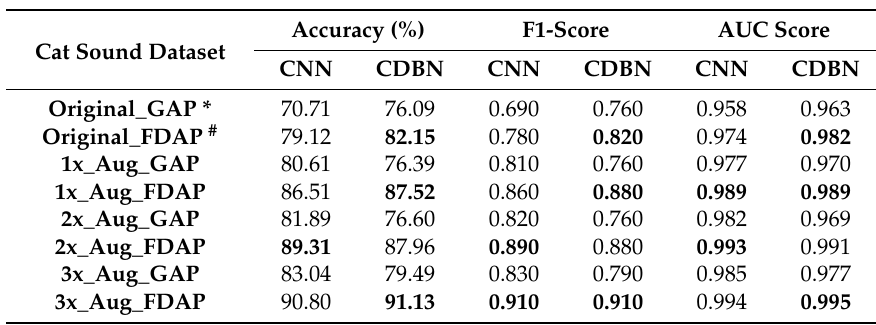
Table 3. The accuracy, F1-Score and area under ROC curve comparison of CNN and CDBN feature using ensemble classifier on original and augmented datasets. The advantage of FDAP over GAP in each layer feature map of two networks using various datasets are denoted by “GAP” and “FDAP” at the end of corresponding dataset. Bold numbers mark the best-performing algorithm(s) for a dataset using FDAP in a learned feature of the network.